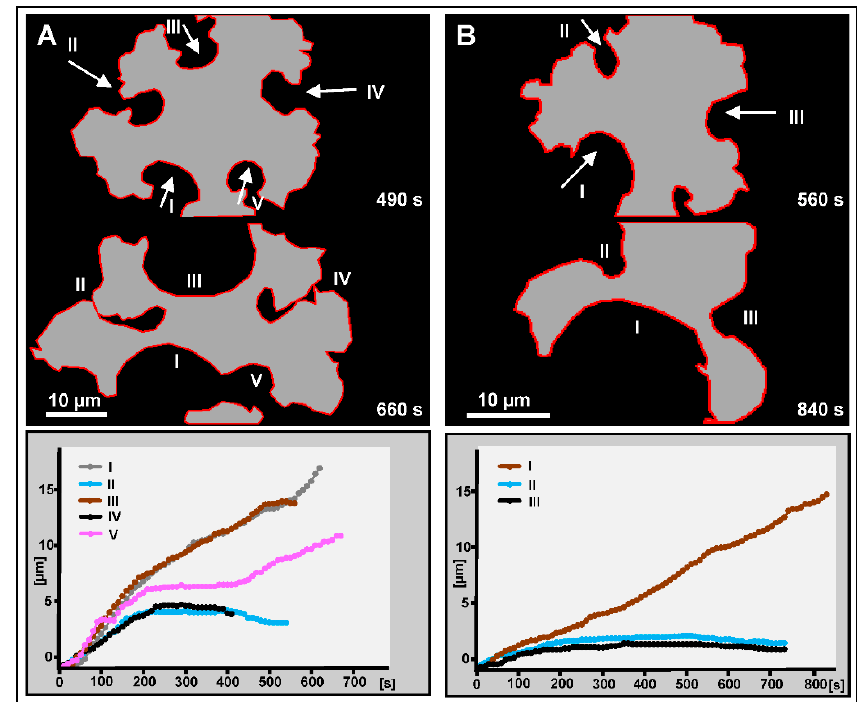
Figure 7. Progression and arrest of unilateral furrows in the myosin-II-null cells shown in the time series of Figures 5 and 6. ( A ) The cell shown in Figure 5 and in supplementary Video S5 forms two progressing furrows (I and III) and two furrows that stop growing (II and IV). Furrow V enters a phase of arrest before it merges with the broad furrow I and continues propagating as part of a joint furrow. ( B ) The cell shown in Figure 6, with furrow I continuously progressing, and furrows II and III coming to a halt. The top and middle panels show the cell boundaries at earlier and later stages of furrow incision. The indicated times correspond to the time scales in Figures 5 and 6, respectively. Zero-time in the curves is set to the beginning of furrow ingression.